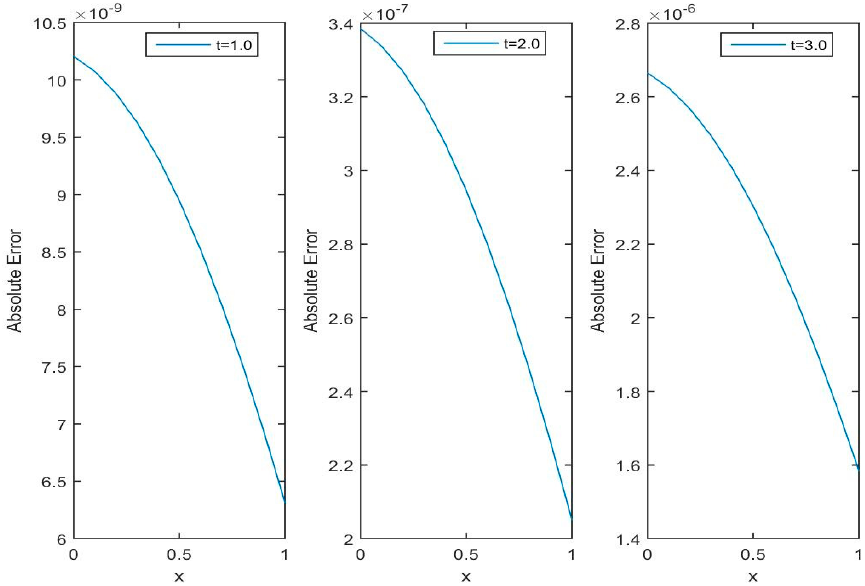
Figure 6. Comparison of exact and approximate solution for Test Problem 2.